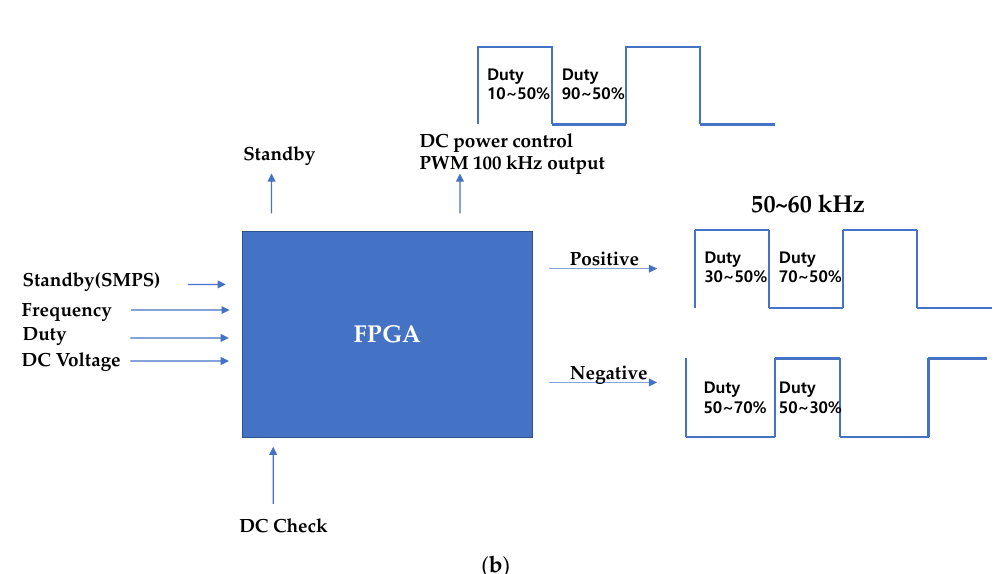
Figure 7. Block diagrams of ( a ) generator configuration and ( b ) PWM signal generation from the FPGA board.